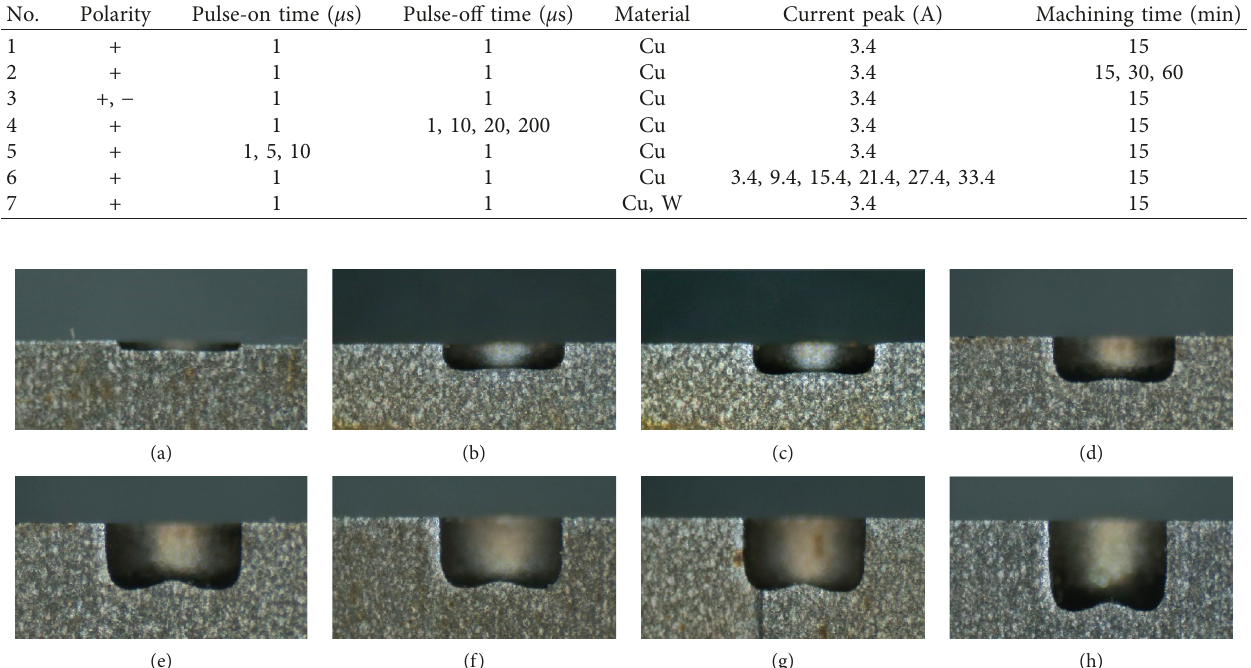
Table 1: Experimental conditions.